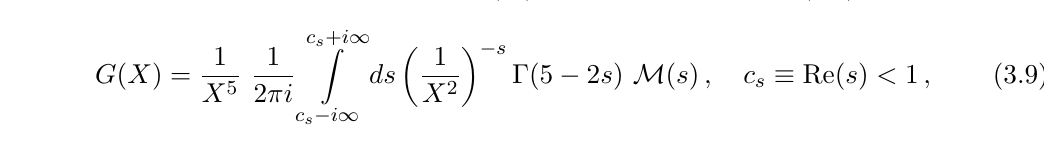
in Fermi units for 0